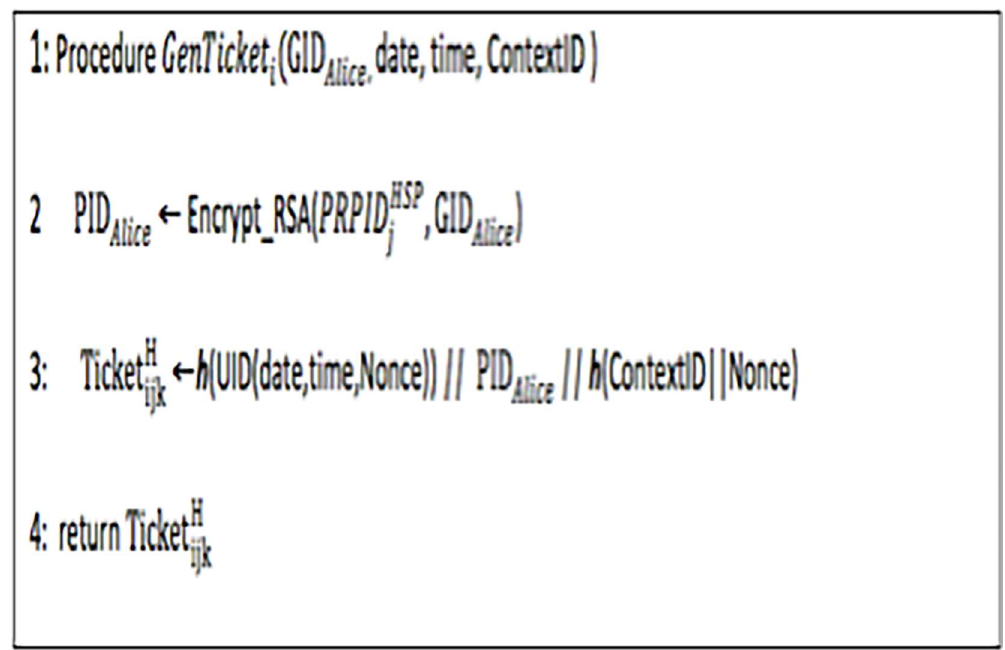
Fig 3. Algorithm 3: Generation of Ticket